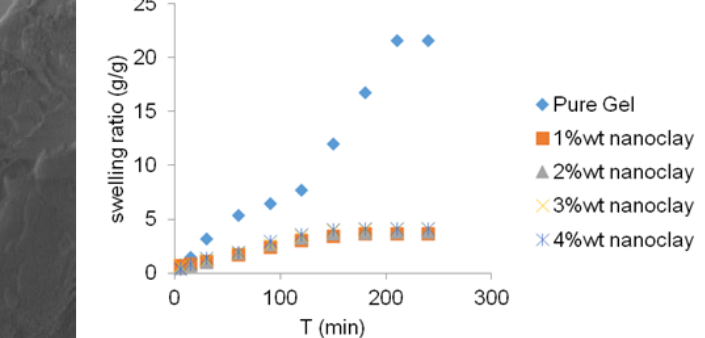
Fig. 10. Swelling ratio of hydrogels vs time.